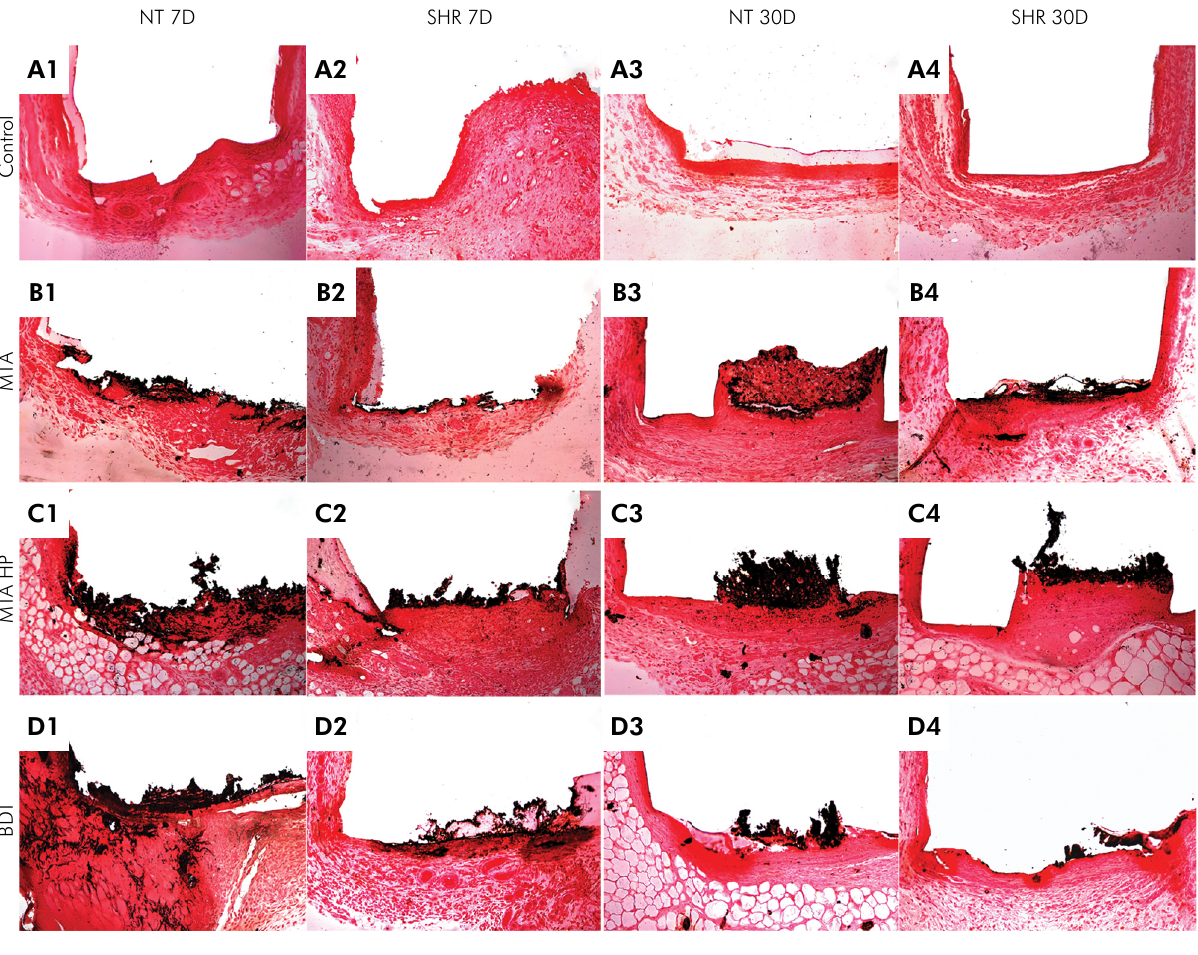
Figure 2. Representative images of biomineralization determined by von Kossa staining under normotensive/hypertensive conditions (NT/SHR). The black areas represent presence of calcifications. MTA, MTA HP, and BDT induced biomineralization, which was not observed in the control group. MTA HP induces similar mineralization under normotensive/hypertensive conditions in both periods of analysis. More consistent biomineralization was observed in MTA and BDT under normotensive condition at 7 and 30 days (Scale bars: 200 μ m; Original magnification: 100×). *Mineral Trioxide Aggregate (MTA), High-plasticity MTA (MTA HP), and Biodentine ®